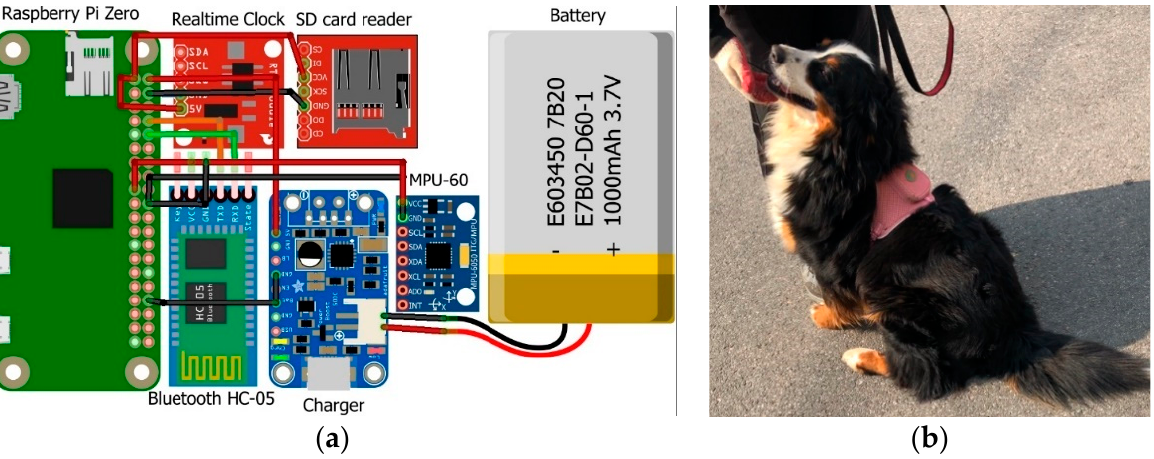
Figure 1. Smart costume: ( a ) The main parts of the smart costume are shown. They are Raspberry Pi Zero, RTC module, HC-05 Bluetooth module, MPU-6050 sensor, SD card reader, 3.7 v Li-Ion battery, and charger. ( b ) The fully constructed smart costume on a dog.